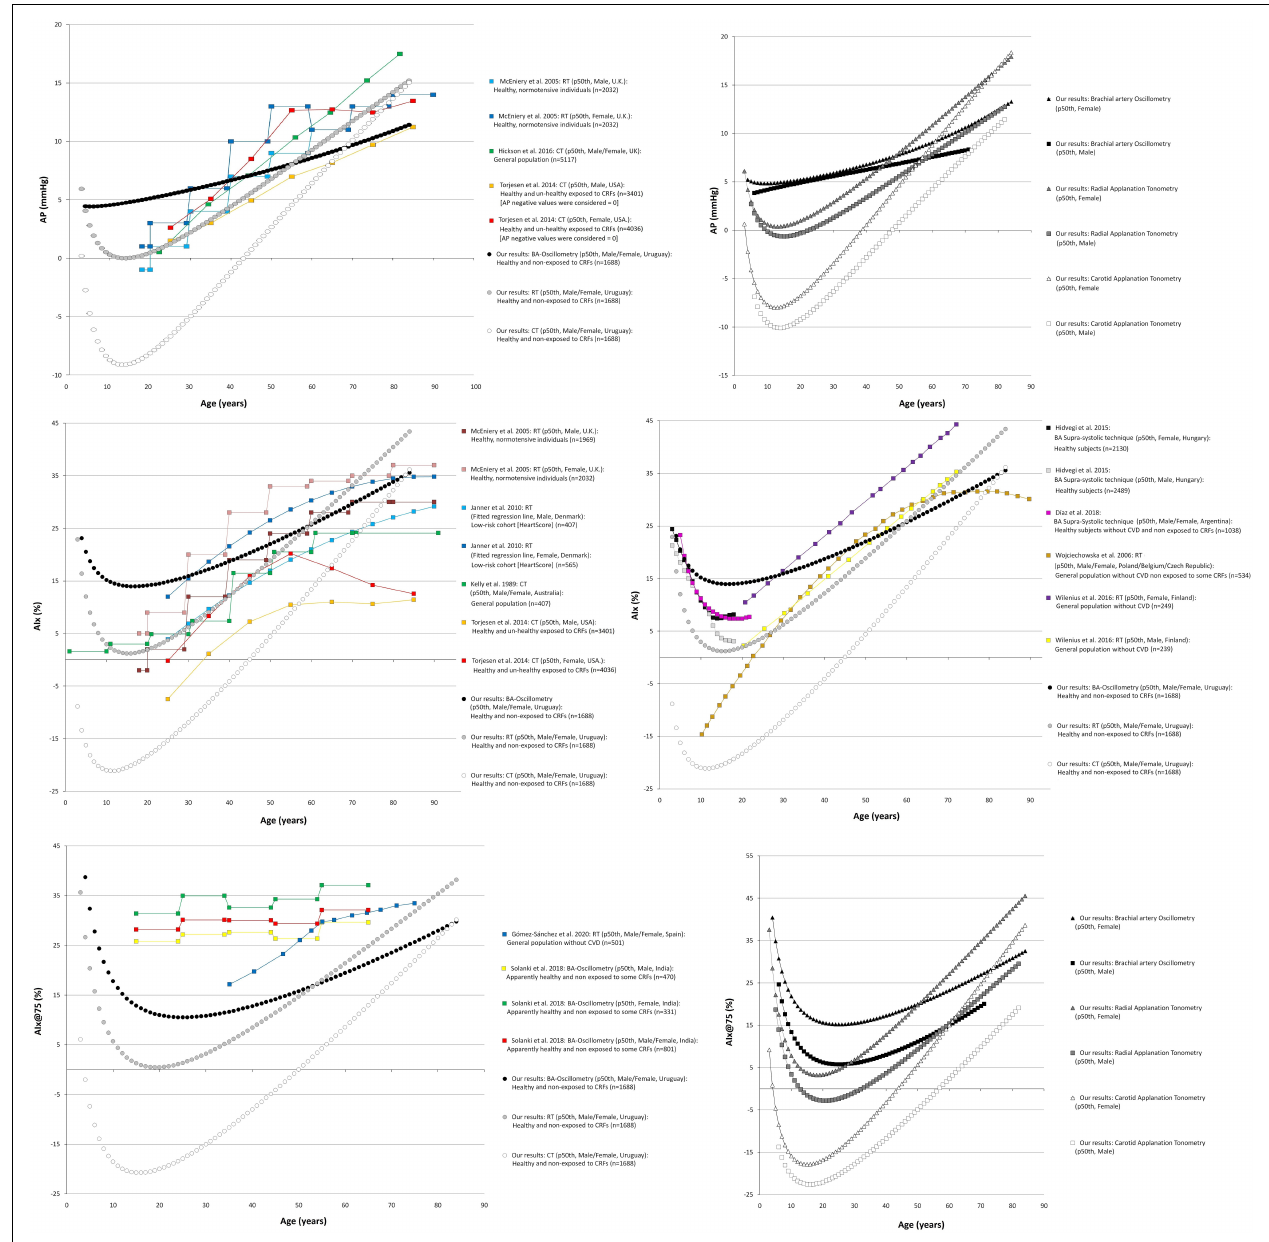
FIGURE 5 | Augmentation pressure (AP), Augmentation Index (AIx), and heart rate-corrected AIx (AIx@75) age-related profiles. Left and right middle panel: Comparison between curves obtained in our study (p50th) and mean values or p50th obtained by other authors. CT, carotid applanation tonometry; CVD, cardiovascular disease; CRFs, cardiovascular risk factors; RT, radial applanation tonometry; U.K., United Kingdom; United States, United States of America; BP, blood pressure; BA, brachial artery. Right top and bottom panel: Age-related profiles (p50th) for males and